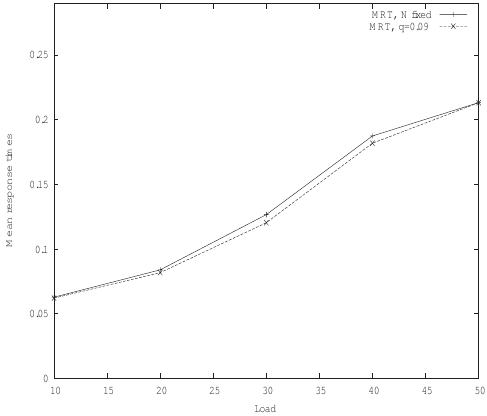
Figure 12. Mean Response times for both cases.